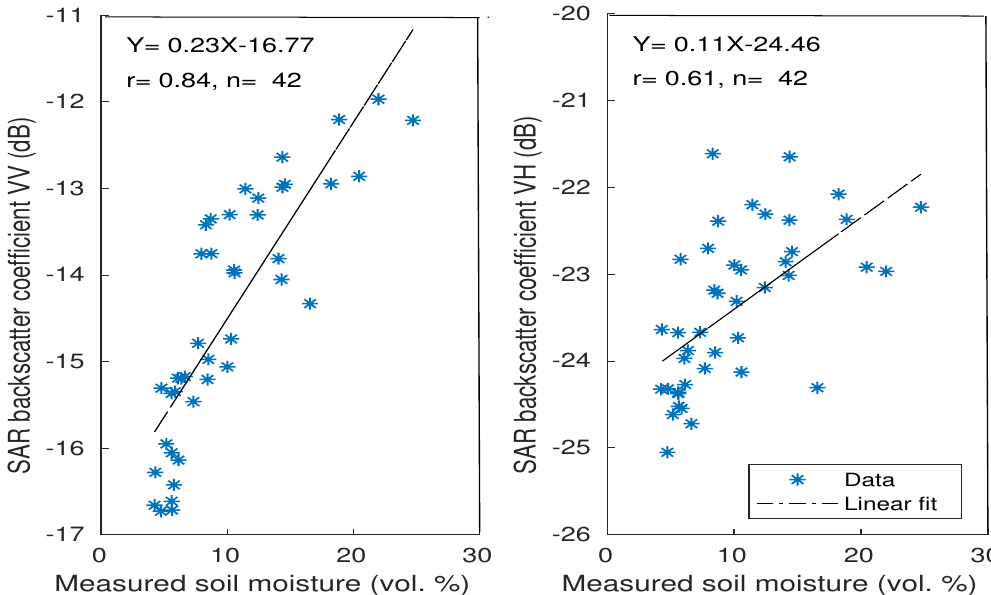
Figure 3. The relationship between SAR on-board Sentinel-1 backscatter coefficient and measured soil moisture at 5 cm for both polarizations: VV ( left ) and VH ( right ). The linear regression lines are also